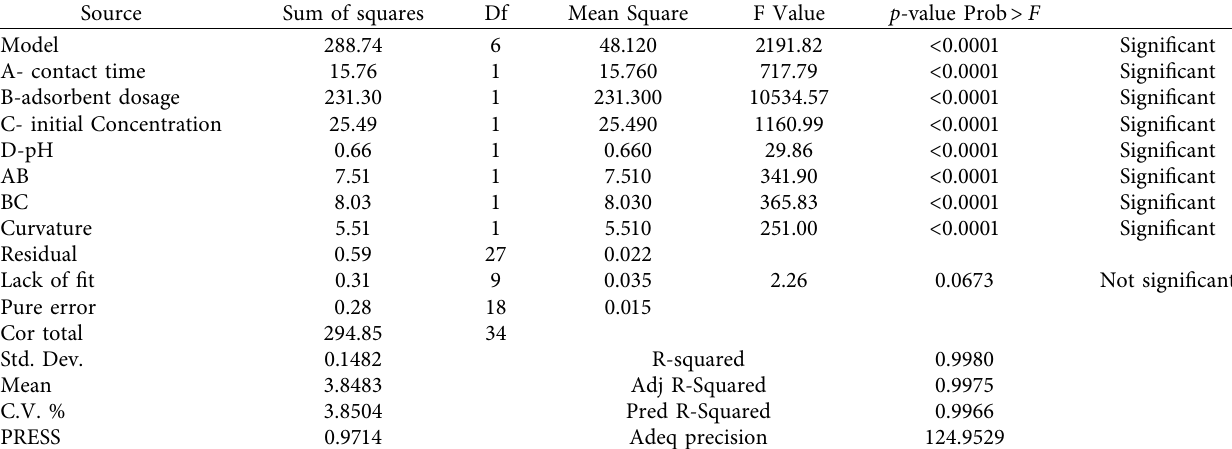
Table 1: Anova (analysis of variance) for 2-level factorial of MB adsorption